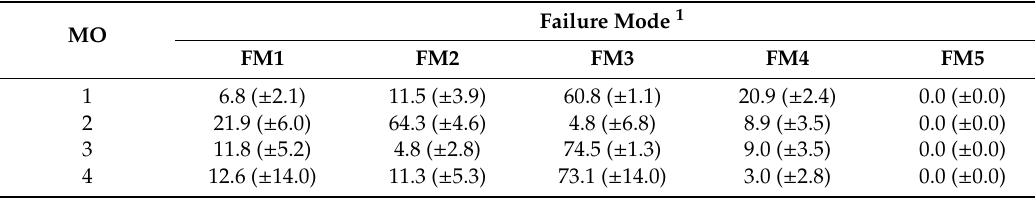
Table 5. Failure mode percentages (%) of the four manufacturing options (MOs) from the end-notched flexure (ENF) tests.